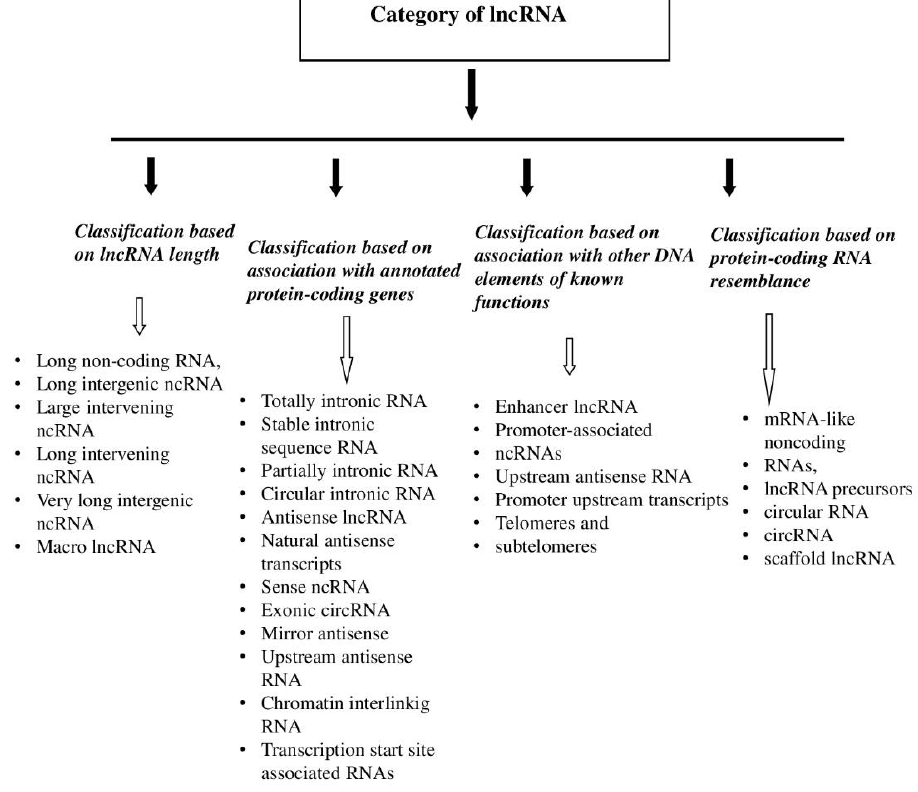
Figure 1. Classification of